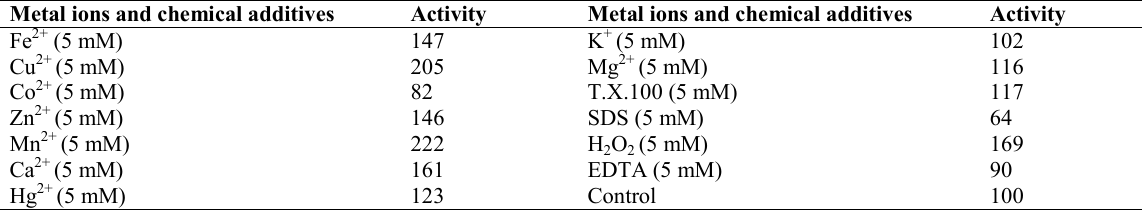
123 Control 100